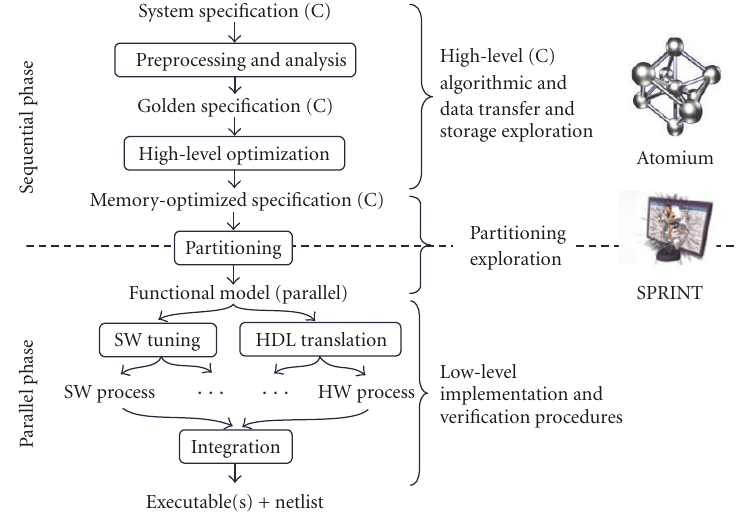
Figure 1: Systematic C-based design